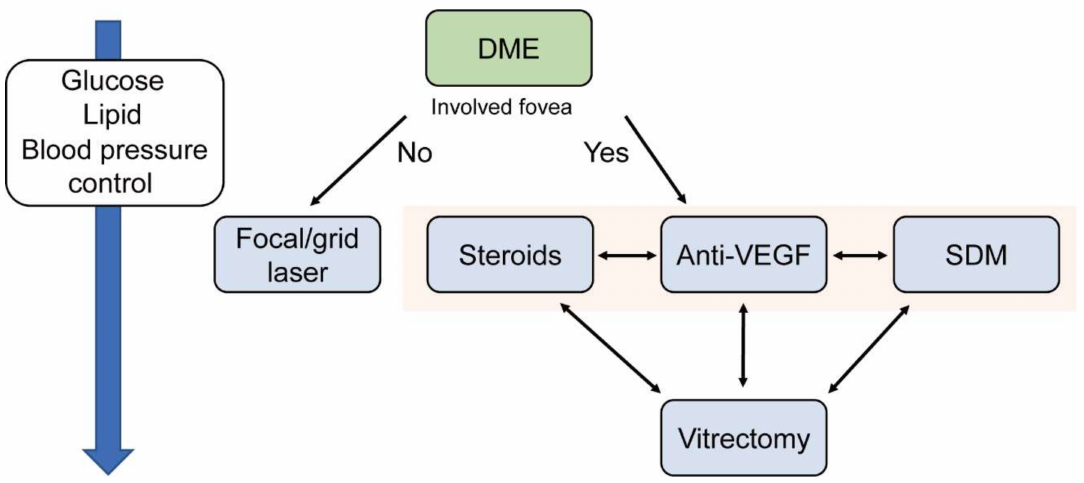
Figure 3. A flowchart of suggested treatment for diabetic macular edema (DME). The strategy of treatment is decided by whether the edema includes the fovea or not. Controlling levels of glucose, lipid, and blood pressure is crucial at any stage. SDM; subthreshold diode laser micropulse photocoagulation, DME; diabetic macular edema.